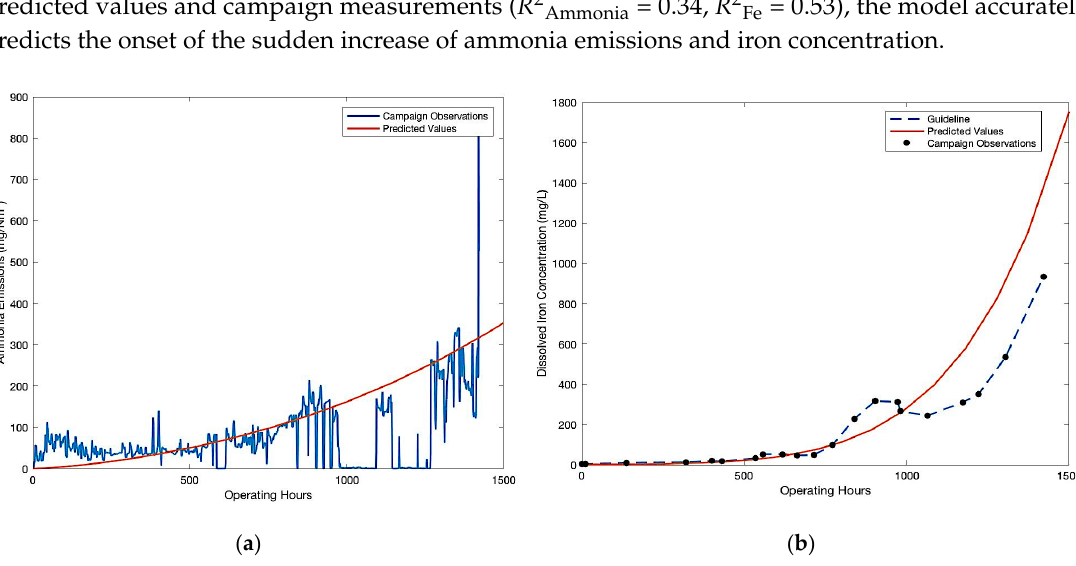
Figure 4. Comparison of the modelled predictions with EnBW’s pilot plant observations for; ( a ) Ammonia emissions; and ( b ) dissolved iron concentration. Guideline (in red) has been used to represent the trend in the observed values of iron concentration.